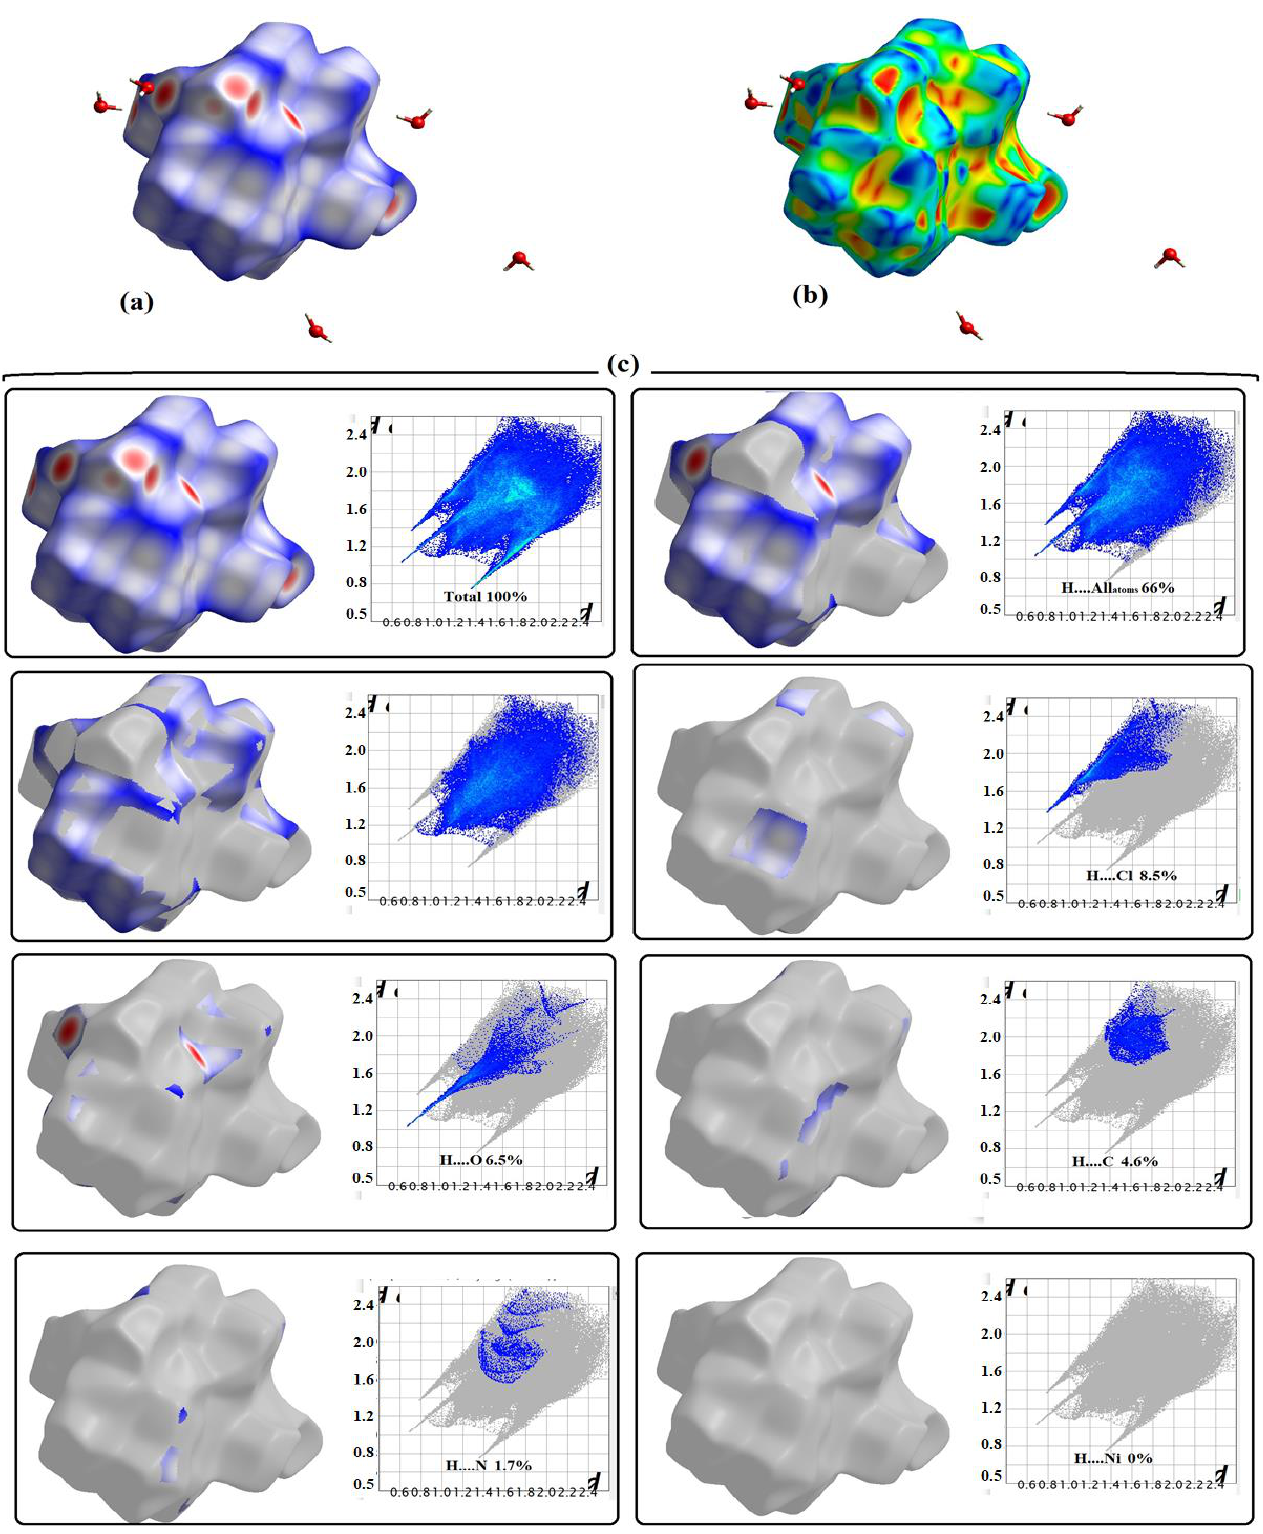
Figure 3. ( a ) d norm , ( b ) shape index and ( c ) 2D-FP over the {[Ni(tptz)Cl(H 2 O) 2 ][Ni(tptz)(H 2 O) 3 ]}3Cl.5H 2 O.